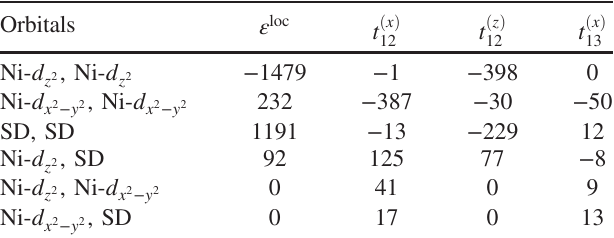
TABLE I. Local single-particle terms and selected hoppings of the derived Wannier Hamiltonian. All energies are in meV. Orbitals ε loc t ð x Þ